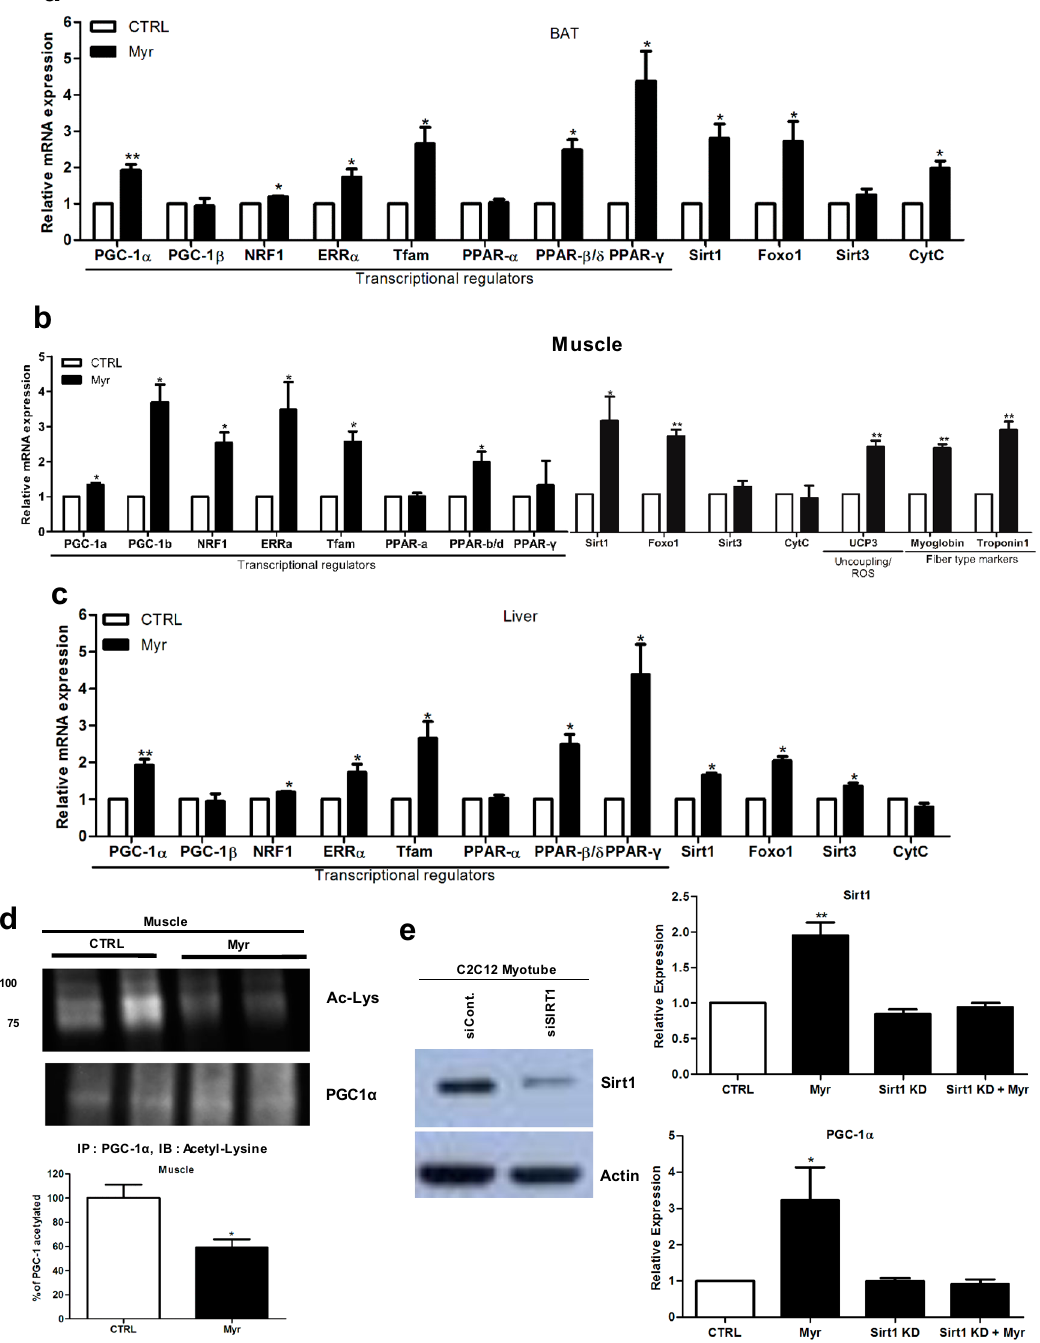
Figure 3. Myricetin increased gene expression important for mitochondrial function and biogenesis in mice. ( a – c ) Relative mRNA expression levels of key genes related to mitochondrial function as measured by RT-qPCR in the BAT ( a ), gastrocnemius muscle ( b ), and live ( c ) from PBS or myricetin-treated mice (n = 3~4 animals/ group). Data represent mRNA levels relative to β -actin and are shown as means ± SEM. ( d ) Representative western blots and quantification showing the relative amount of acetylated versus total PGC-1 protein in gastrocnemius muscle. PGC-1 α was immunoprecipitated (IP) from nuclear extracts and then immunoblotted with either an anti-acetylated lysine antibody to determine the extent of PGC-1 α acetylation (Ac-Lys) or an anti-PGC-1 α antibody to determine the total amount of PGC-1 α . N = 4 animals/group. ( e ) C2C12 myotubes were transfected with a Sirt1 siRNA or a control siRNA. Following 24 hr incubation with DMSO or myricetin (100 μ M), cells were harvested for protein and RNA extraction. A representative western blot showing SIRT1 protein expression in these cells is shown. Actin was used as a loading control. The mRNA expression levels of Sirt1 and PGC-1 α were determined by RT-qPCR. Values represent the mRNA levels relative to β -actin, Unpaired Student’s t-tests, * = P < 0.05, ** = P < 0.005, *** = P < 0.0005. Values represent means ±